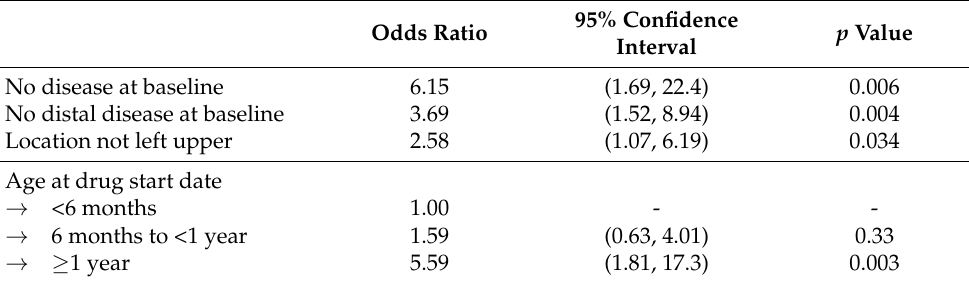
Table 5. Vein status at study endpoint, by patient, and vein characteristics: multivariable analysis for the outcome of minimal